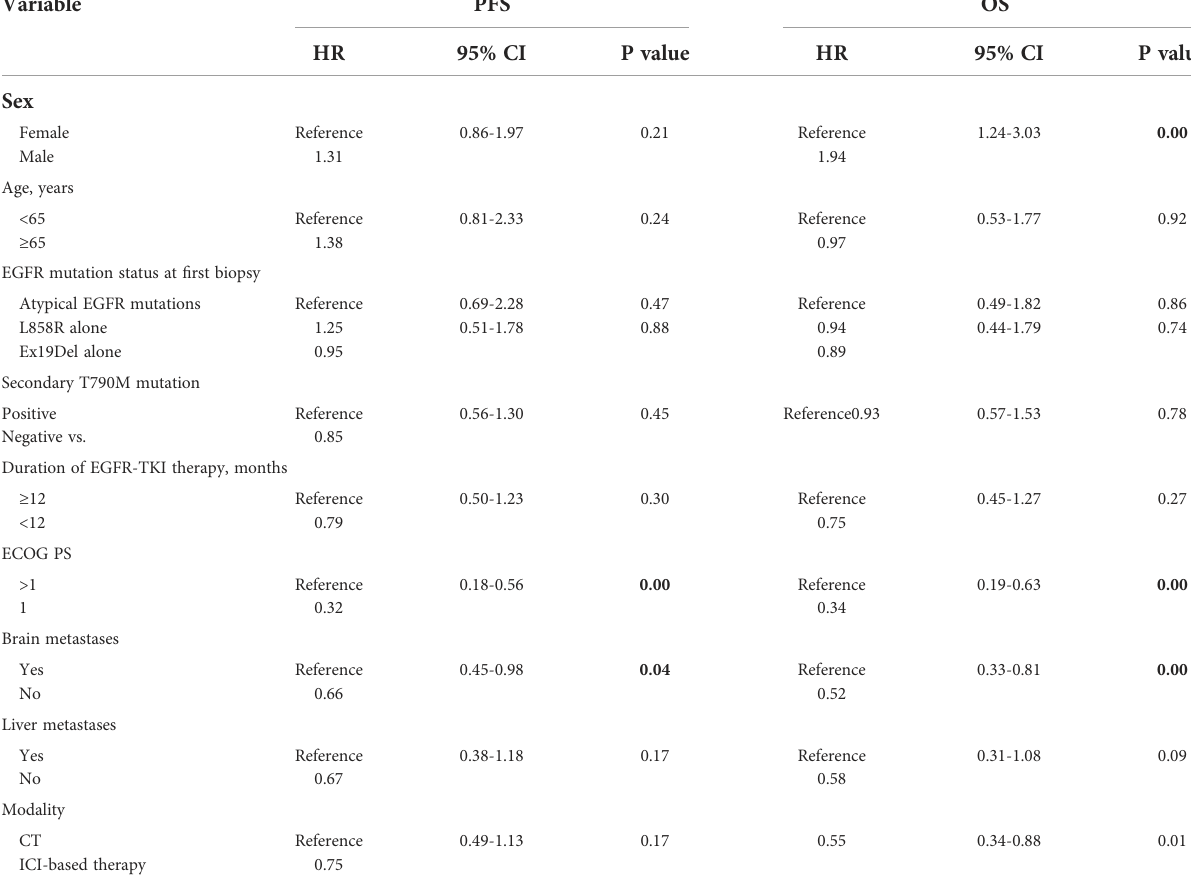
TABLE 2 Multivariable analysis of PFS and OS in patients who received ICI-based therapy and chemotherapy after developing EGFR-TKI resistance. Variable